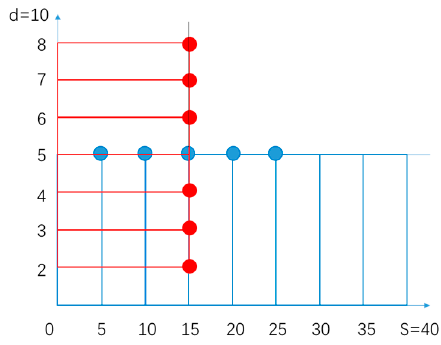
Figure 8. Principle of the “vertical and horizontal halver method”.